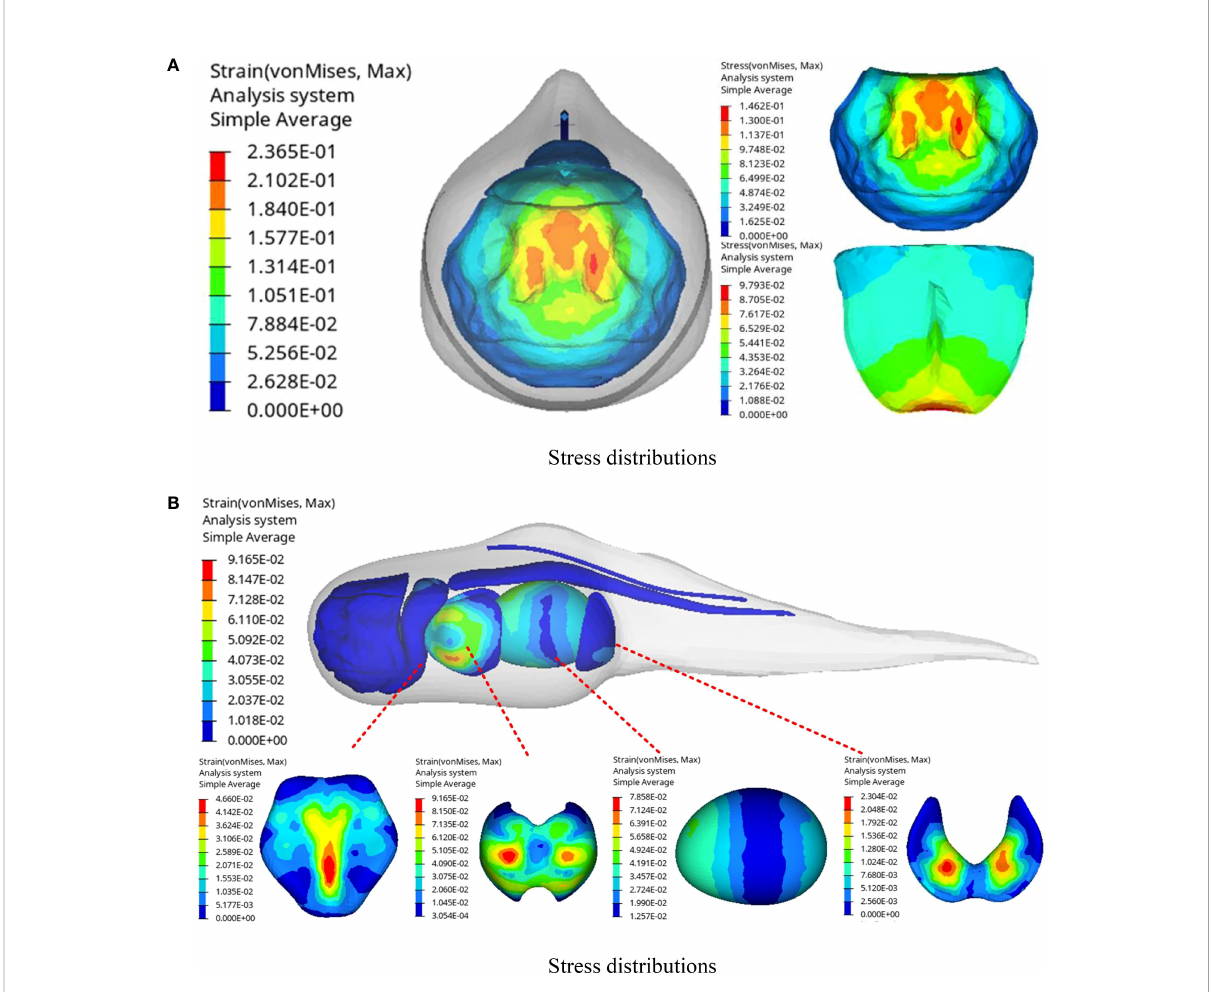
FIGURE 10 Stress and strain distribution of hadal snail fi sh during collision (A) stress distributions; (B) strain